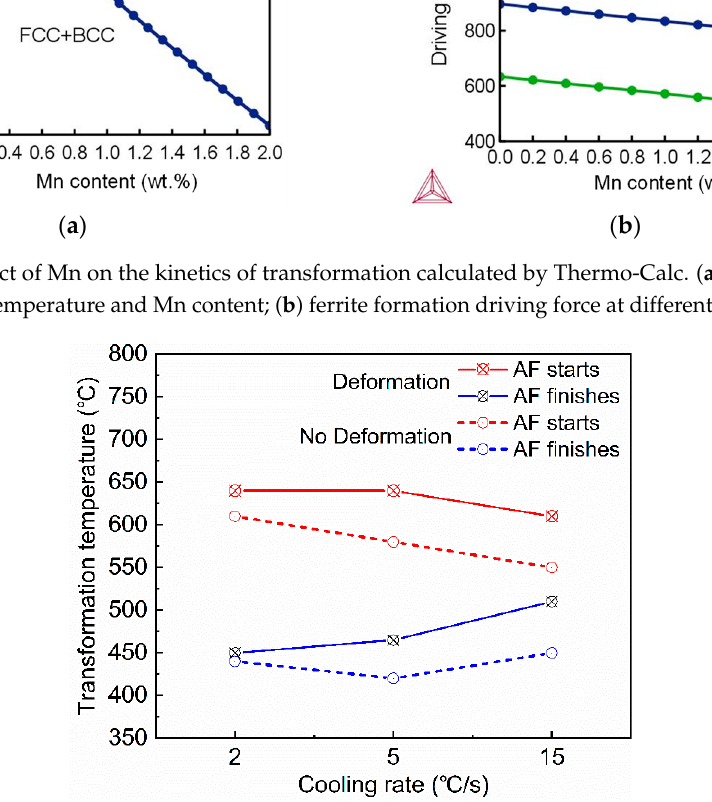
Figure 12. Effect of cooling rate on formation temperature of AF in TC# steel.